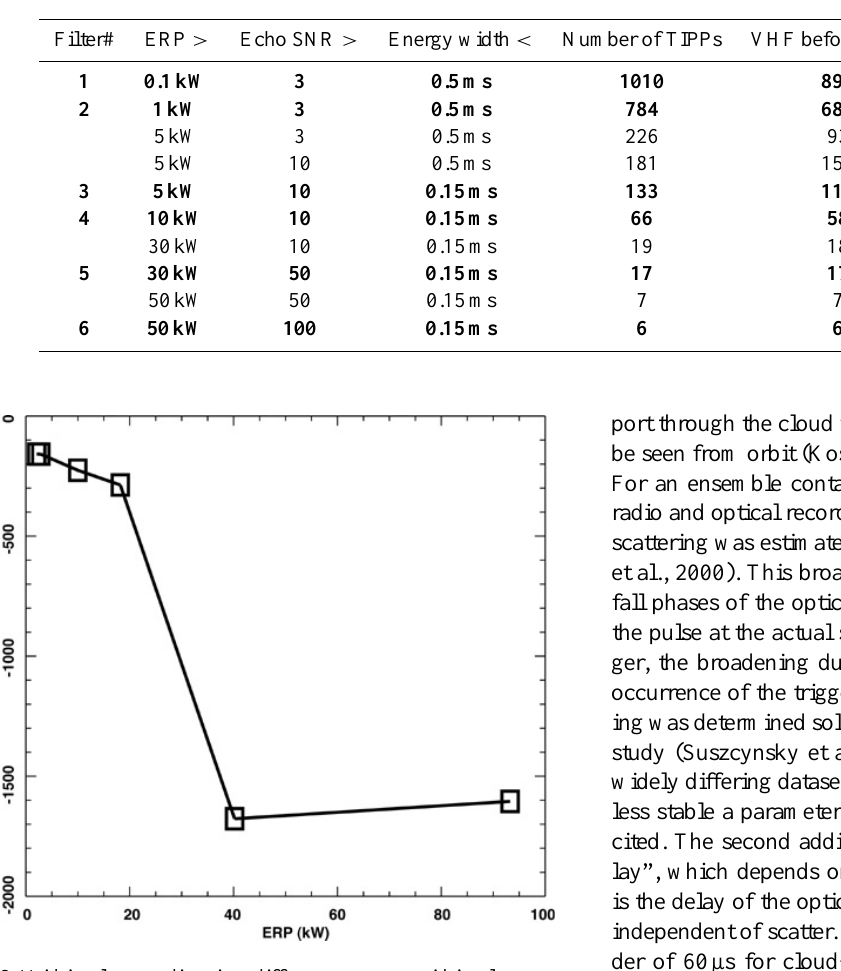
Fig. 3. Within-class median time difference, versus within-class me- dian ERP, for HUMR TIPPs. Classes defined in Table